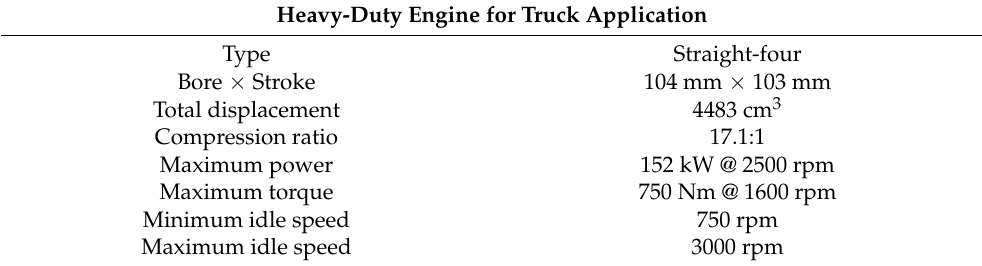
Table 3. IS engine main technical characteristics.